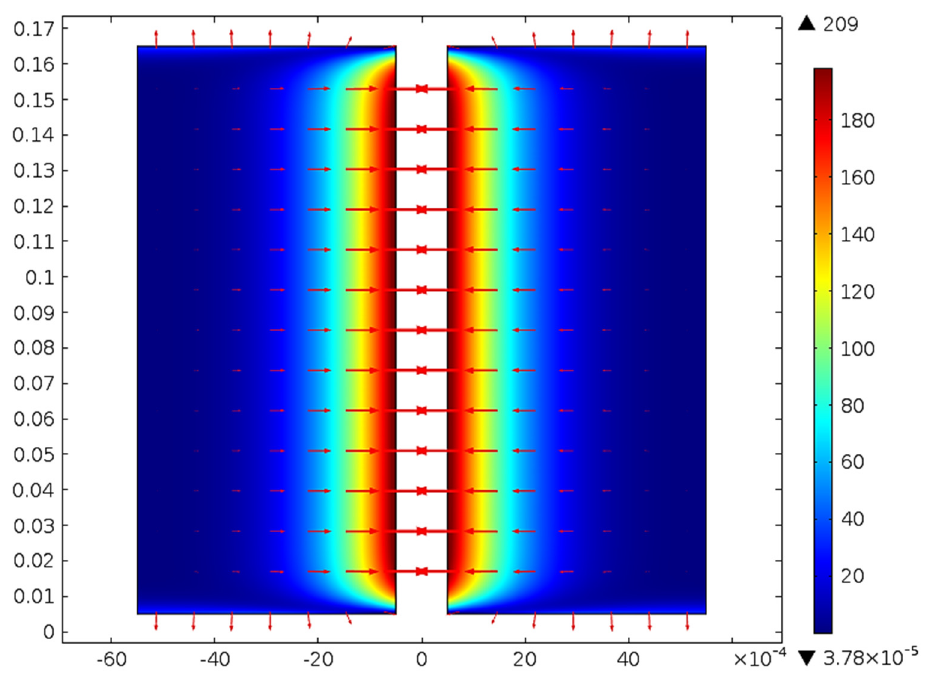
Figure 10. PV cell surface resistive losses distribution and vector of current for Profile 3 under the short circuit condition, x-axis is the bus-bar direction (m) and y-axis is the finger direction